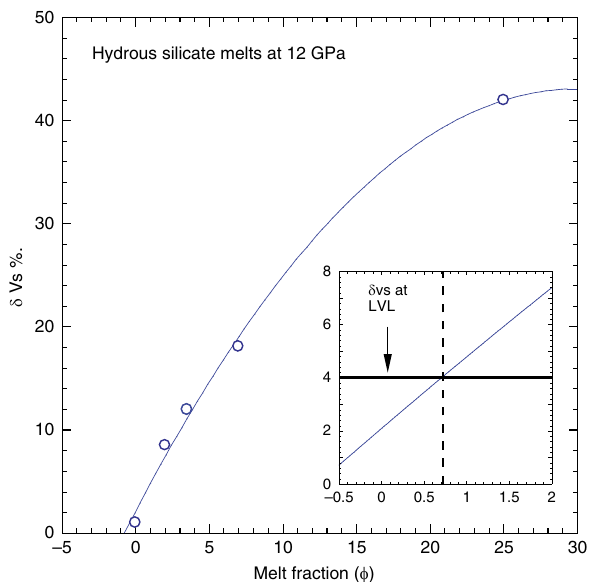
Fig. 5 Density of hydrous silicate melts occurring at the base of the Earth ’ s upper mantle. The density of hydrous melt is determined by the third-order Birch – Murnaghan equation of state (see Methods section for details). The yellow shaded area indicates the possible range of densities obtained for the 0.7% melt fraction with 33wt.% FeO and 16.5 wt.% H 2 O. The calculated density for melt with 33wt.% FeO and 5 wt.% H 2 O in indicated in black broken line. The experimental data for hydrous rich melt 27 (M05) and dry peridotite melt 62 (S10) are shown for comparison. The mantle densities are taken from PREM 45 with corrections applied for the thermal